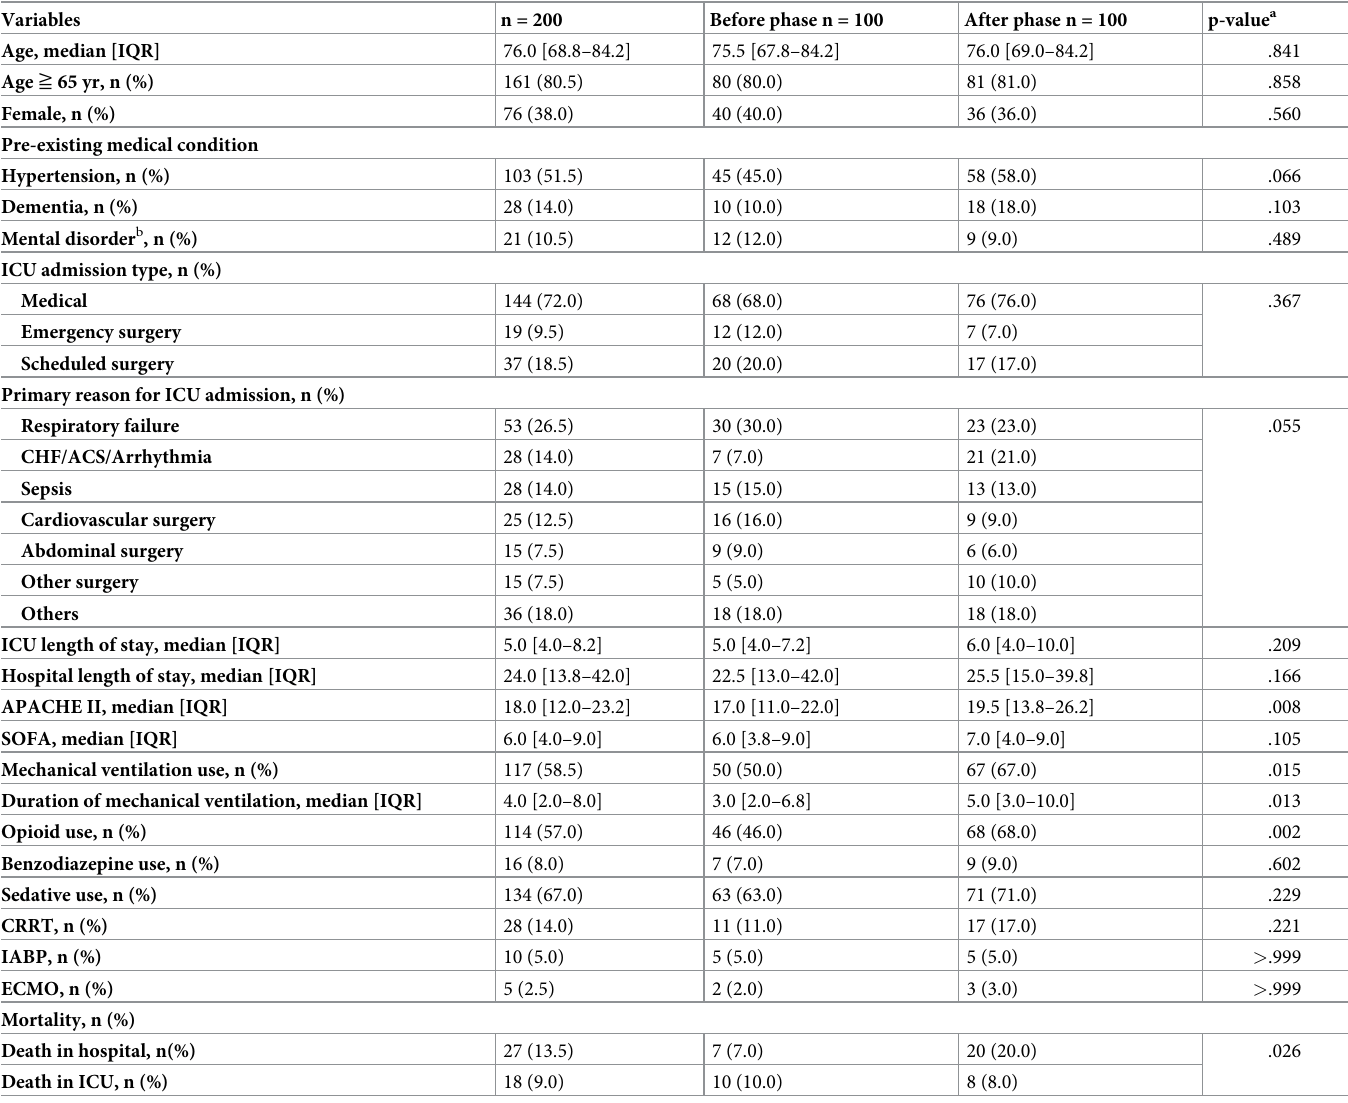
Table 1. Patient characteristics before and after the no-visitation